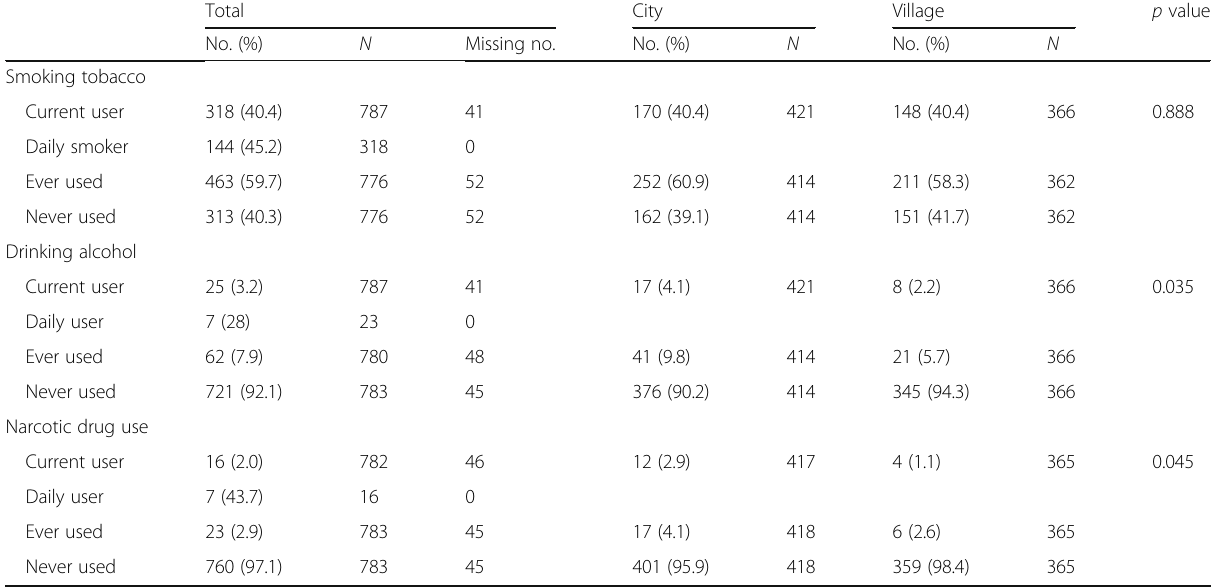
Table 2 Substance practice, smoking tobacco, alcohol, and narcotic drug use Total City Village Missing no.